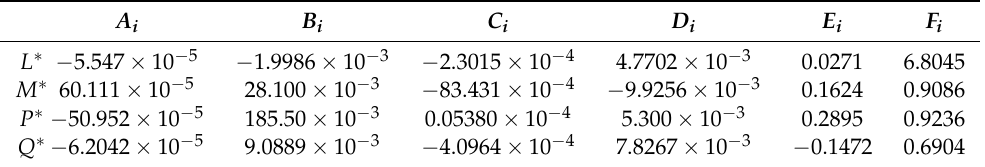
Table 1. Polynomial coefficients for Equation